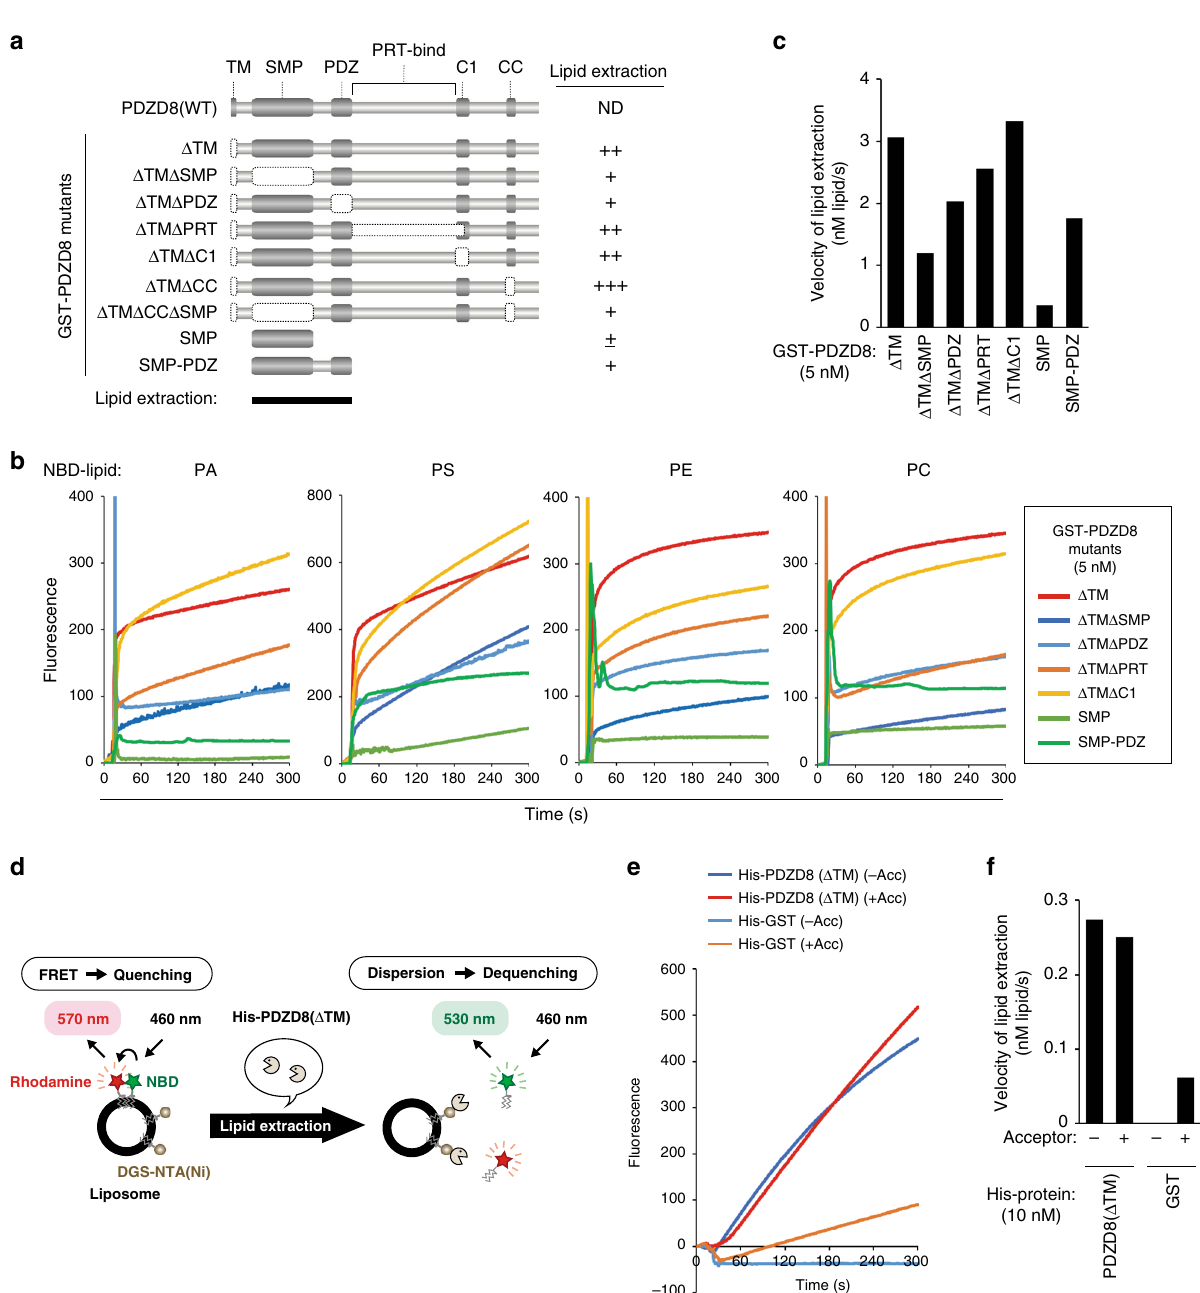
Fig. 4 Delineation of the region of PDZD8 responsible for lipid extraction. a Domain structure of mouse PDZD8 deletion mutants. A summary of the lipid extraction activity of the mutants is shown on the right. PRT, protrudin; ND, not determined. b Phospholipid extraction activities of PDZD8 deletion mutants with PA, PS, PE, and PC. c Initial velocity of lipid extraction by PDZD8 mutants with PS measured in b . d Schematic representation of the liposome- FRET assay performed with DGS-NTA(Ni) and His 6 -tagged proteins. e PS extraction activity of His 6 -PDZD8( Δ TM) or His 6 -GST (negative control) measured with donor liposomes containing DGS-NTA(Ni) and in the absence ( − ) or presence ( + ) of acceptor (Acc) liposomes. f Initial velocity of lipid extraction by His 6 -PDZD8( Δ TM) measured in e